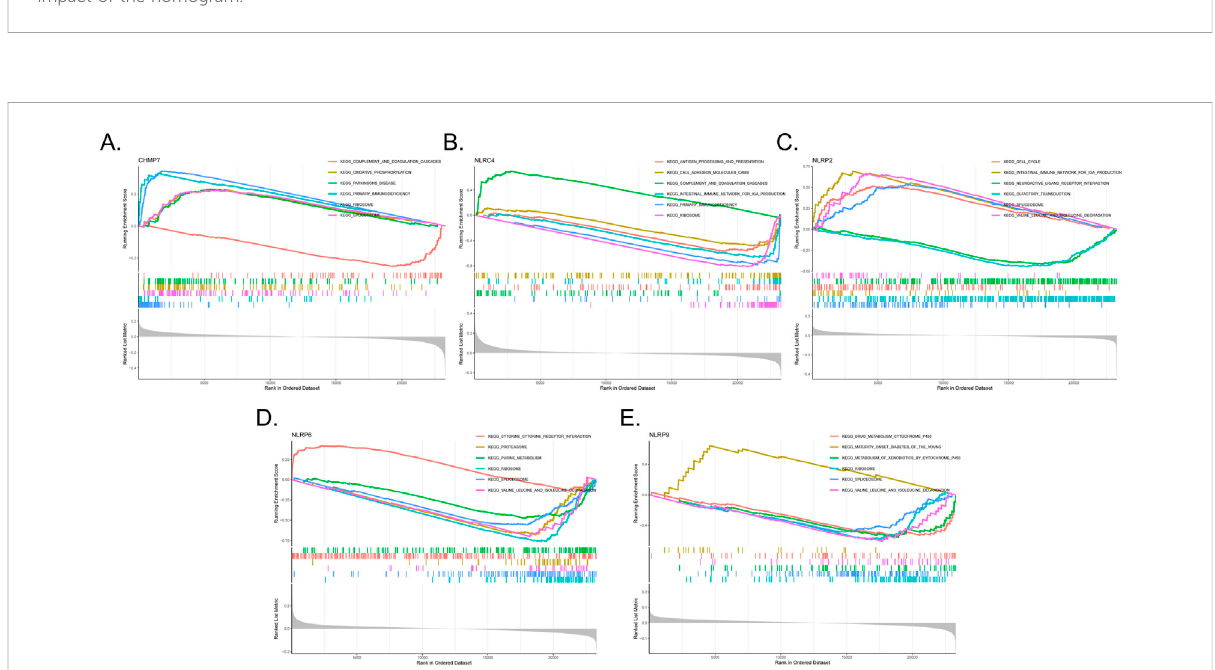
FIGURE 5 Single-gene GSEA-KEGG pathway analysis in CHMP7 (A) , NLRC4 (B) , NLRP2 (C) , NLRP6 (D) , and NLRP9 (E) .